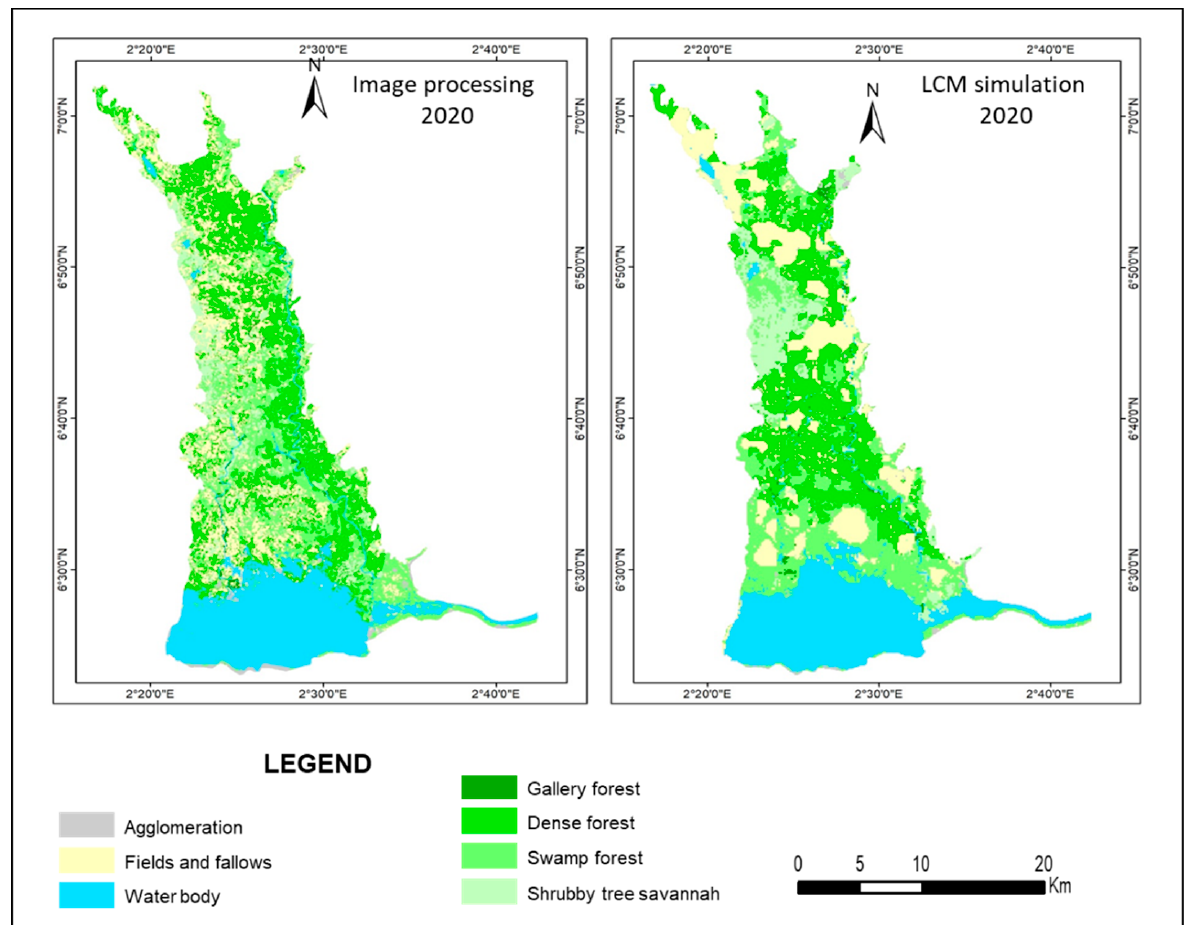
Figure 6. Comparative mapping of the 2020 classification and simulation. Table 6. Comparative statistics of areas for model validation. Type of